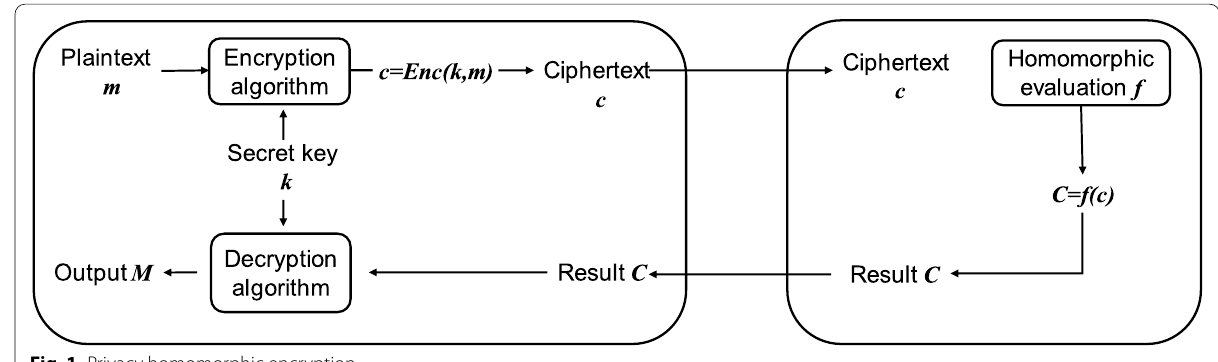
Fig. 1 Privacy homomorphic